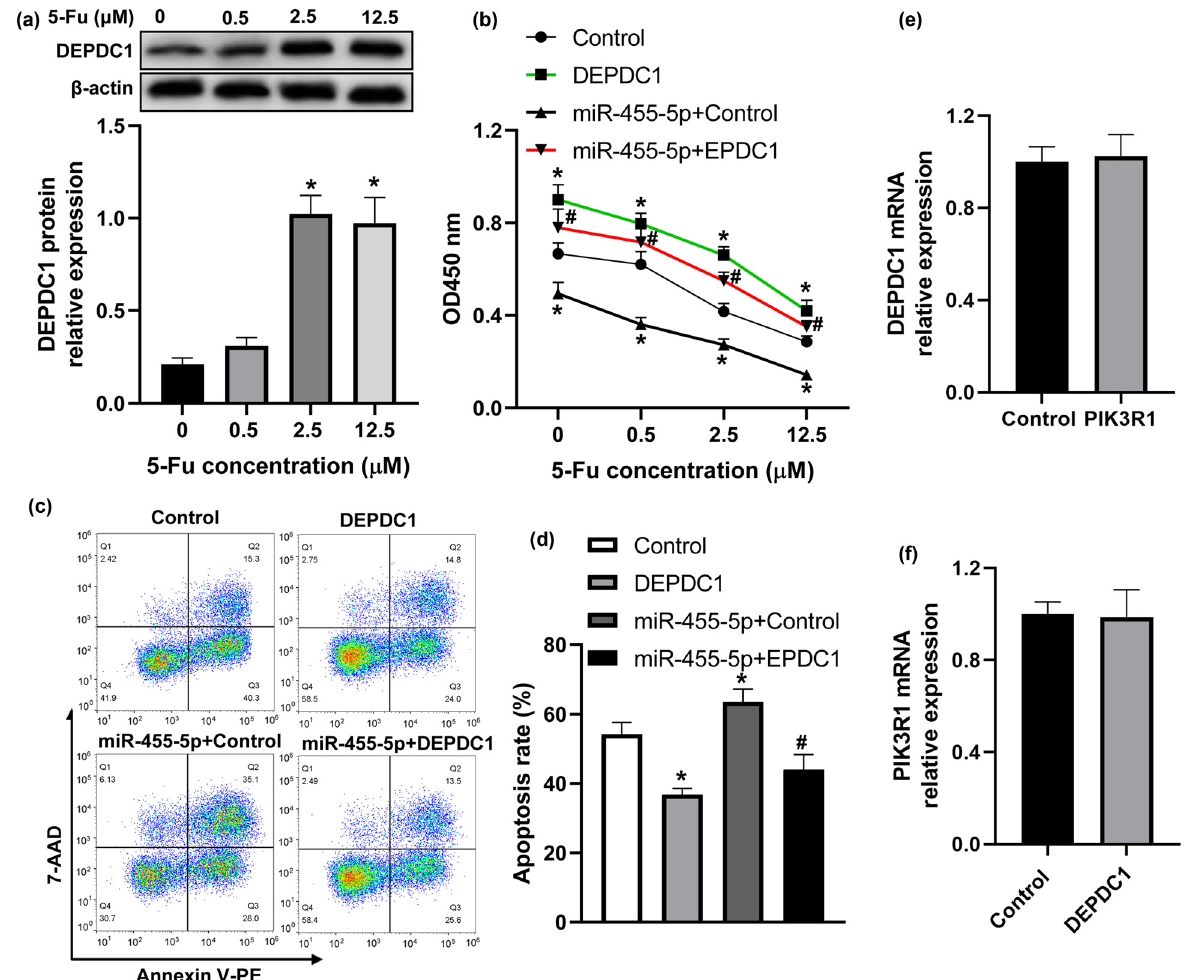
Figure 5: miR - 455 - 5p enhanced 5 - Fu sensitivity of CRC cells via modulating DEPDC1. ( a ) DEPDC1 protein expression was analyzed by western blot in HT - 29 cells after treatment with di ff erent concentrations of 5 - Fu ( 0, 0.5, 2.5, and 12.5 μ M ) for 48 h. ( b ) Cell viability was detected by CCK - 8. ( c and d ) The apoptosis of HT - 29 cells was measured by fl ow cytometry. ( e ) DEPDC1 expression was analyzed by real - time PCR in HT - 29 cells transfected with PIK3R1 overexpressing plasmid or pcDNA3.1 control plasmid. ( f ) PIK3R1 mRNA expression in HT - 29 cells transfected with DEPDC1 overexpressing plasmid or pcDNA3.1 control plasmid. * P < 0.05 vs the control group, # P < 0.05 vs the miR - 455 - 5p + control